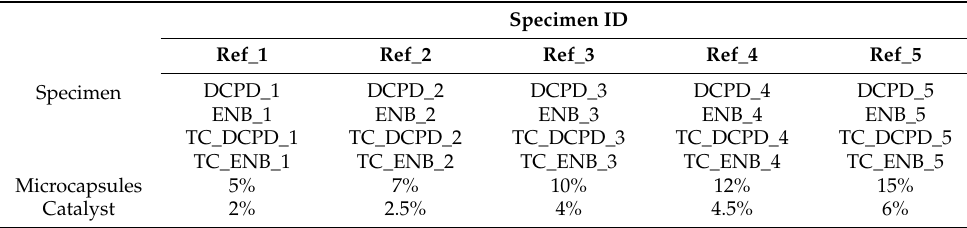
Table 4. Impact specimen